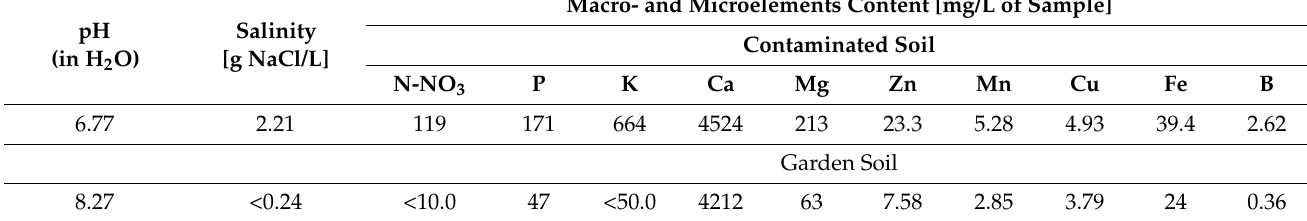
Table 1. Chemical characteristics of cultivation sites.